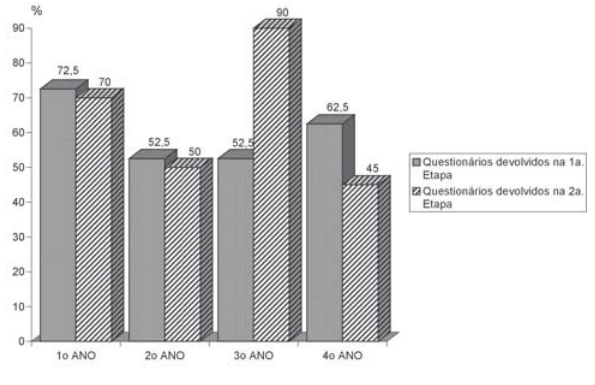
FIGURA 1 - Análise da quantidade de questionários devolvidos pelos estudantes de graduação em odontologia antes (1 a etapa) e após (2 a etapa) palestra informativa